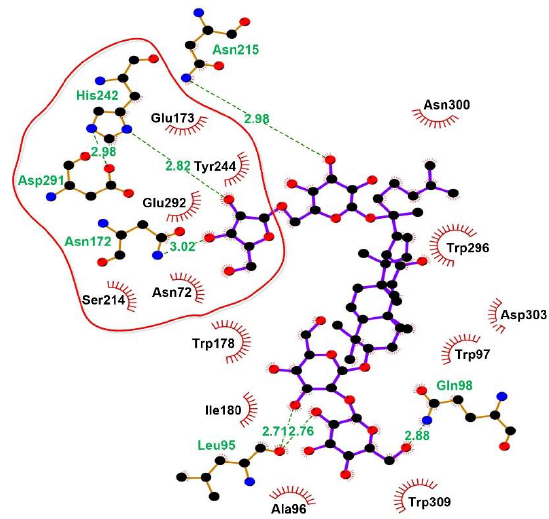
Figure 10. Ligplot output for H-bond and hydrophobic interactions of the amino acid residues of BsAbfA involved in binding with ginsenoside Rc. Hydrogen bonds < 3.1 Å are shown as green dotted